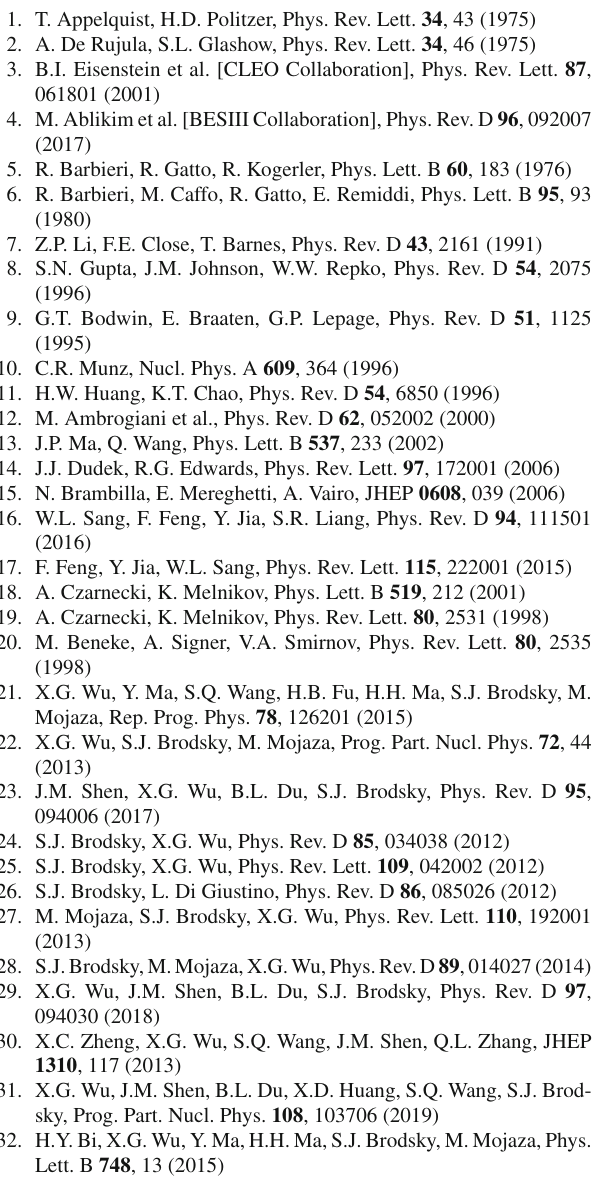
Fig. 5 The NNLO R b -ratios versus the factorization scale μ (cid:12) under conventional and PMC scale-setting approaches. Three typical μ r are adopted, and the PMC prediction is independent to those choices of μ r